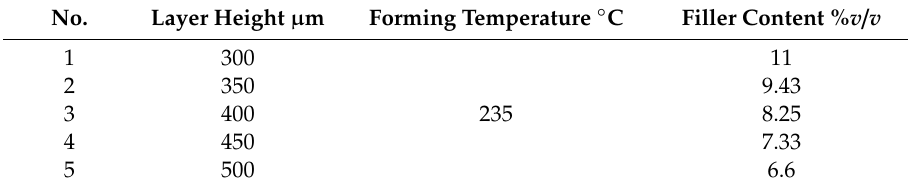
Table 2. Parameters of formed fiber composites, 2nd stage of research.